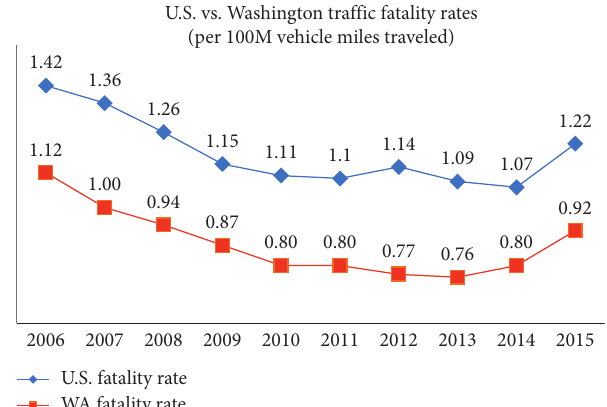
Figure 1: Traffic fatality rates in the U.S. vs. Washington State (per 100M vehicle miles traveled). Source: CLAS (WSDOT) and FARS